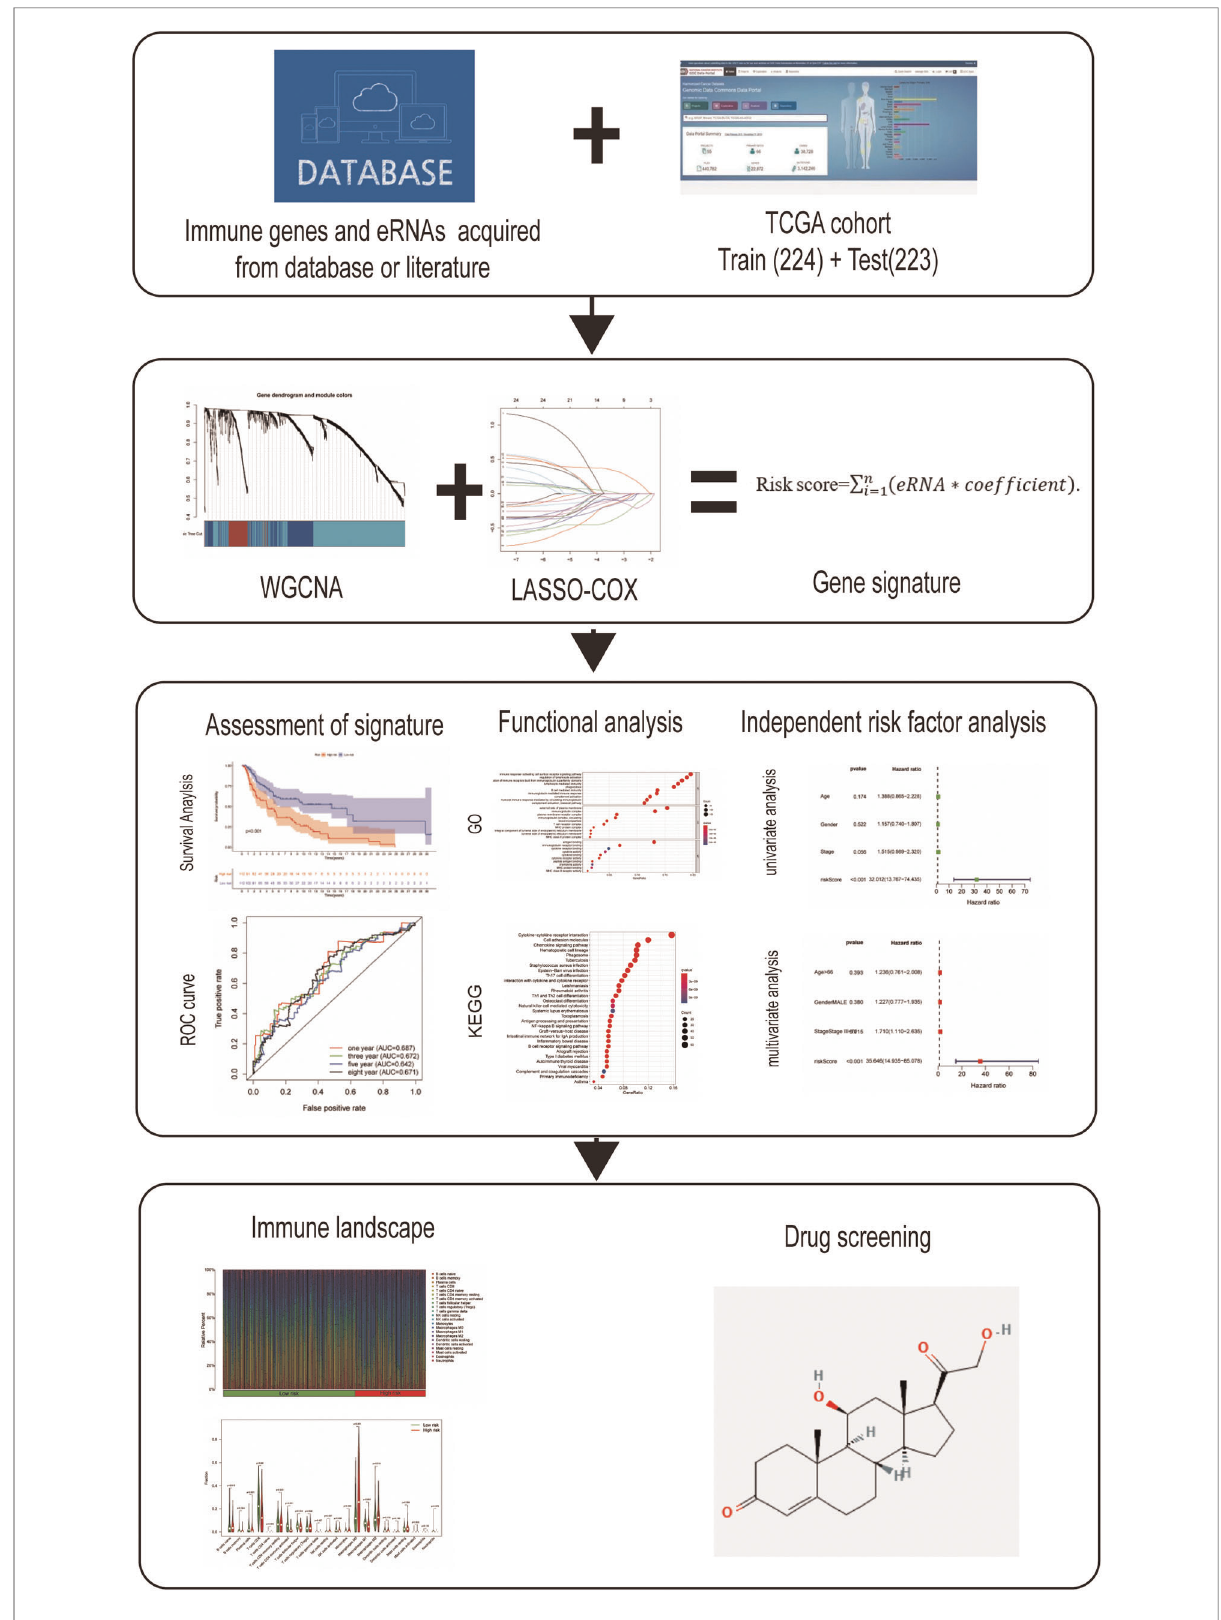
FIGURE 1 Flow diagram of the